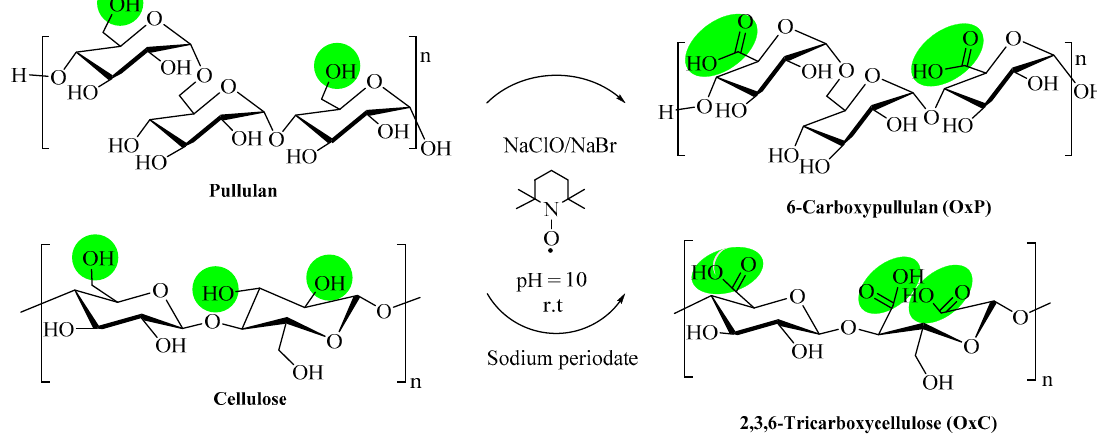
Figure 1. General scheme for the oxidation of pullulan and cellulose, performed in the presence of TEMPO, NaClO, NaBr and sodium periodate, respectively.